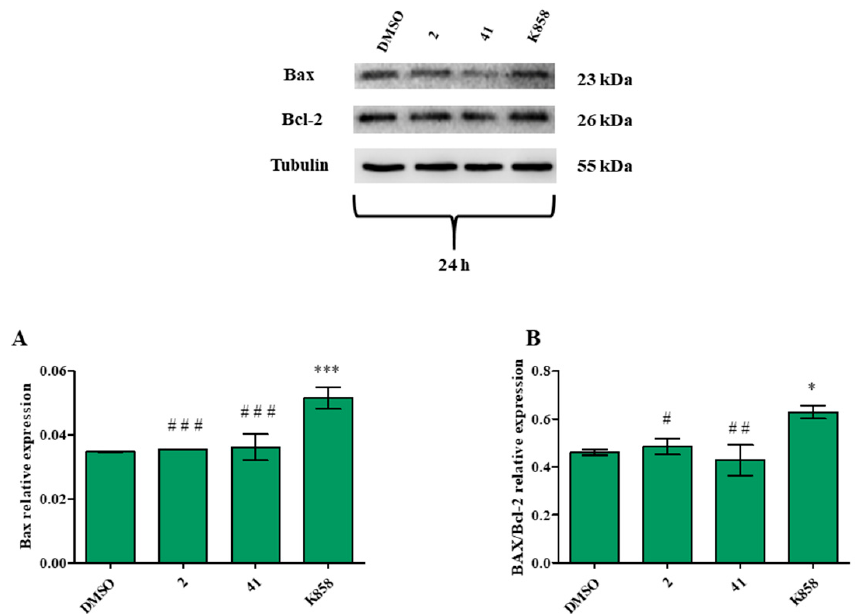
Figure 12. Bax and Bcl-2 protein expression levels in MCF7 cell line treated with 2 (1.5 µ M), 41 (5 µ M), and K858 (10 µ M) for 24 h. DMSO: control vehicle. Data are reported as means ± SD of three independent experiments. Tubulin is used as a loading control. ( A ): The bar graph displays Bax densitometric values normalized on loading control. *** p < 0.0001 DMSO vs. K858; ### p < 0.0001 K858 vs. 2 and 41. ( B ): The bar graph displays densitometric values expressed as mean ± SD of Bax/Bcl-2 ratio normalized on loading control. * p < 0.05 DMSO vs. K858; ## p < 0.0074 K858 vs. 41; # p < 0.05 K858 vs.